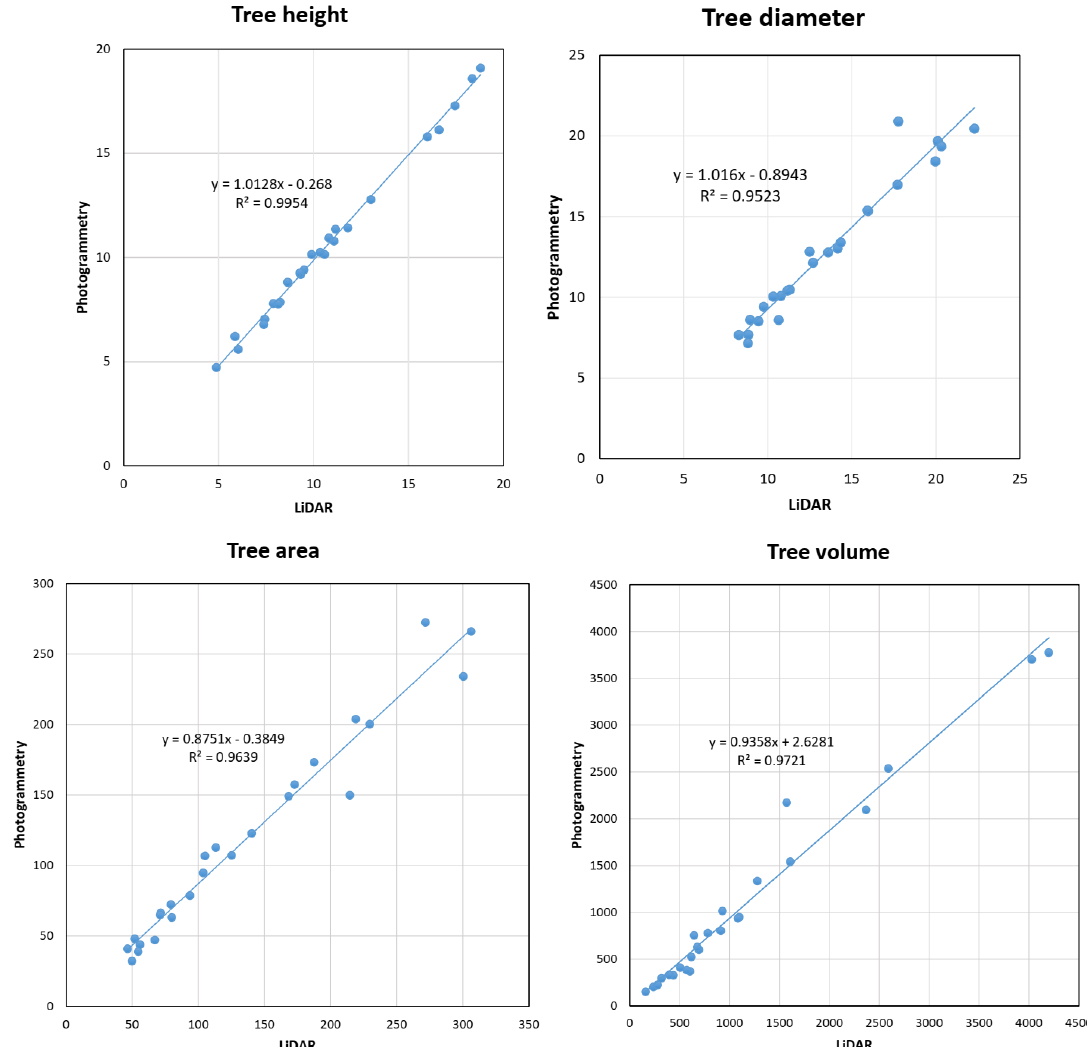
Figure 16. Scatterplots of estimated tree parameters.